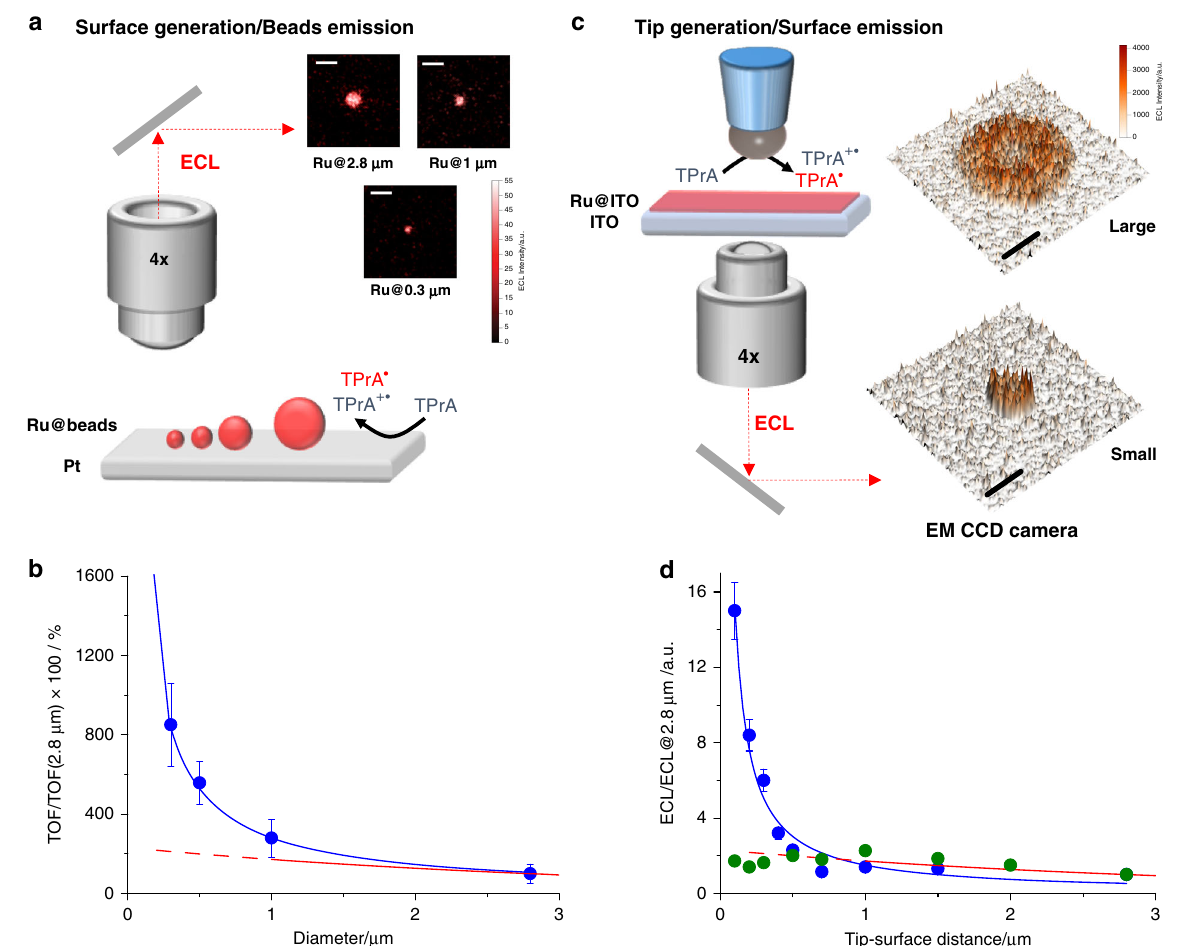
Fig. 2 Spatial map of electrochemiluminescence (ECL) emission. a Schematic representation of the surface generation – bead emission experiment where Ru@beads are magnetic beads labeled with [Ru(bpy) 3 ] 2 + on platinum electrode (Pt) and b turnover frequency (TOF) as a function of bead size (blue curve and dots) and ECL intensity of the ref. 23 (red curve). The inset in a shows the ECL images acquired for beads with different sizes where Ru@2.8 μ m, Ru@ 1 μ m and Ru@0.3 μ m are ECL images of magnetic beads labeled with [Ru(bpy) 3 ] 2 + with a diameter of 2.8, 1, and 0.3 μ m, respectively. Magni fi cation ×100, Scale bar 5 μ m; potential applied, 1.4 V (vs. Ag/AgCl, 3 M KCl); acquisition time, 0.5 s. The TOF is the number of photons emitted in 1 s by a single Ru (cid:2) ECL Þ = n (cid:3) of ½ Ru ð bpy Þ (cid:4) 2 þ ´ time see also Results and “ Supplementary Methods 1 ” ). TOF@2.8 μ m is the turnover luminophore ( TOF ¼ ð ECL 3 Ru @ Bead Bead frequency for 2.8 μ m beads (Ru@2.8 μ m). c Schematic representation of the tip generation – surface emission experiment where Ru@ITO is transparent indium tin oxide (ITO) electrode functionalized with a [Ru(bpy) 3 ] 2 + monolayer as the emitting surface and d ECL intensity as a function of the tip – surface distance for a small electrode (blue curve and dots) and a large electrode (green dots) and ECL intensity of the ref. 23 (red curve). ECL@2.8 μ m is the ECL intensity for 2.8 μ m distance between tip and surface. The inset in c shows the ECL intensity image pro fi le acquired for a small and a large Pt hemispherical electrode at 1.4 V. Magni fi cation ×4, scale bar, 500 μ m. The potentials applied via cyclic voltammetry at a scan rate of 100 mV s − 1 ranged from 0 to 1.4 V (vs. Ag/AgCl 3 M KCl). TPrA: tri- n -propylamine. Error bar shows the standard deviation ( n =